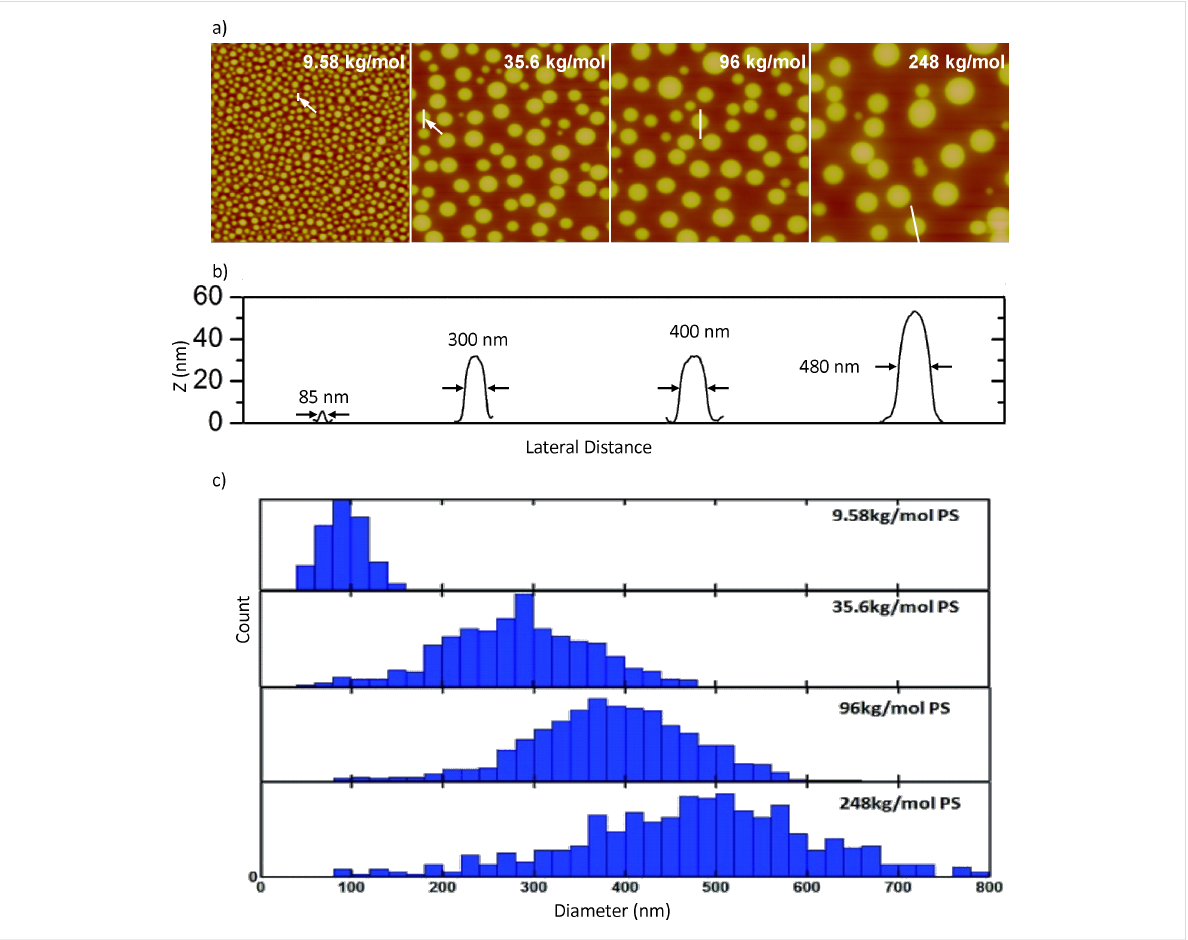
Figure 4: Dependence of the PS island diameter and height by varying the molar mass of PS. (a) AFM images of a polymer blend film formed from various PS samples with molar masses of 9.58, 35.6, 96 and 248 kg/mol. The scan areas of all AFM images are 5 × 5 μ m 2 . (b) Height profiles of selected PS islands of average size (height above the PMMA matrix level). (c) Distribution of the diameters of PS islands of various molar